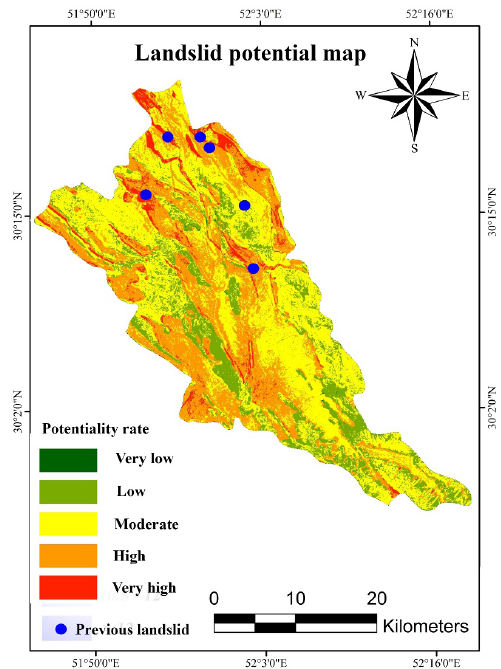
Fig.5 the final provided map and locations of the landslides that were occurred in the last fifteen years